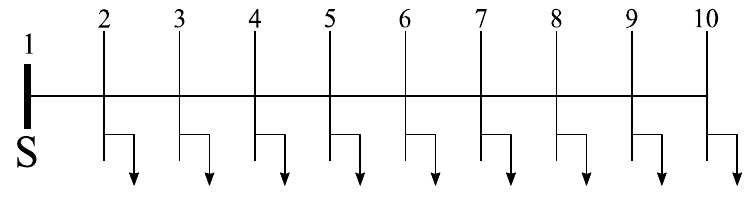
Figure 7. 10-bus distribution test system.